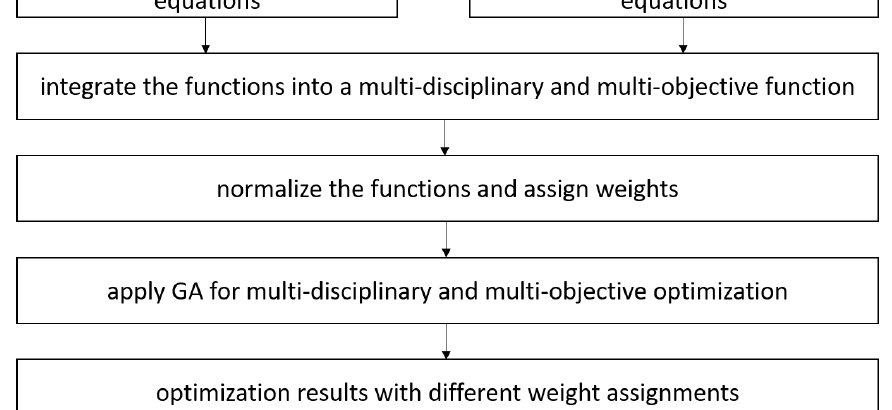
Figure 4. Multi-disciplinary and multi-objective optimization flowchart.